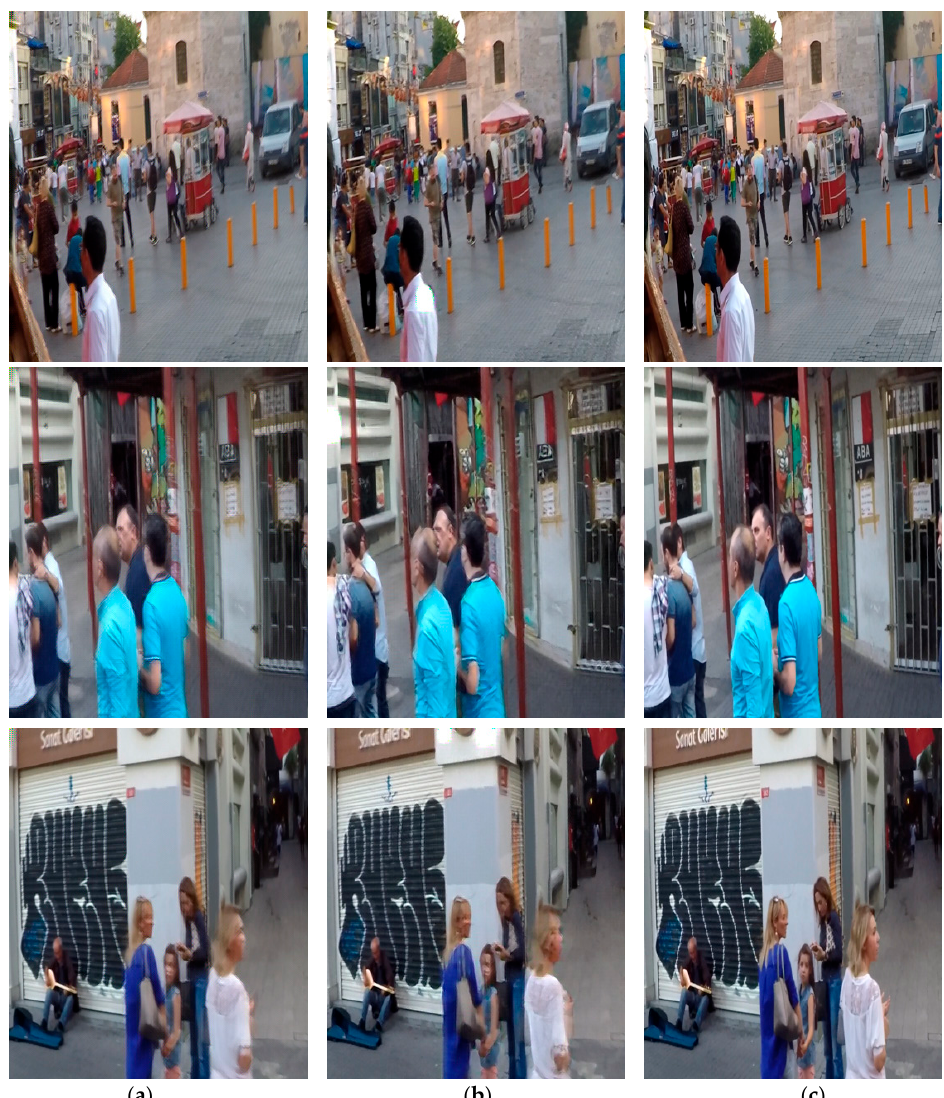
Figure 19. Object images from comparing proposed method with WGAN-GP using content-based methods: ( a ) WGAN with content loss ( b ) Proposed method ( c ) Original sharp image.